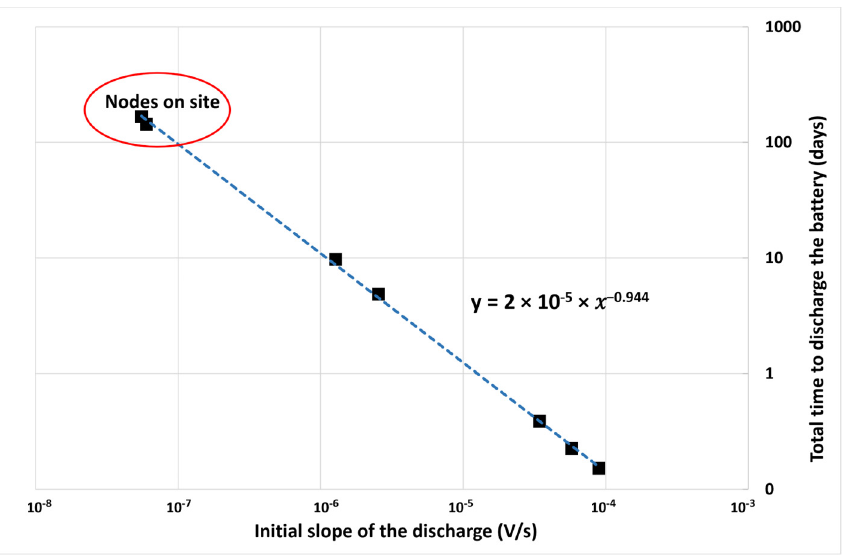
Figure 14. Correlation between the battery lifetime and the value of the initial slope of the discharge.